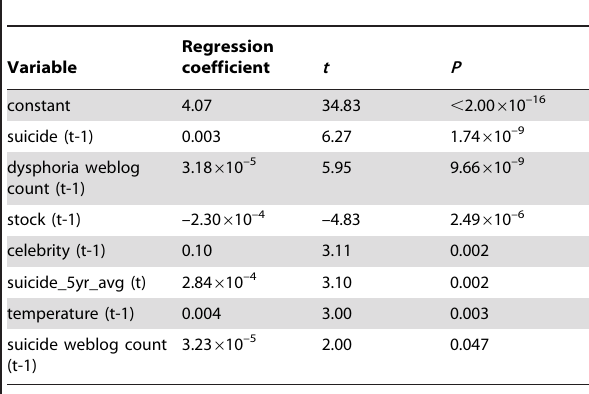
Table 2. Final variables included in the prediction model (adjusted R-squared